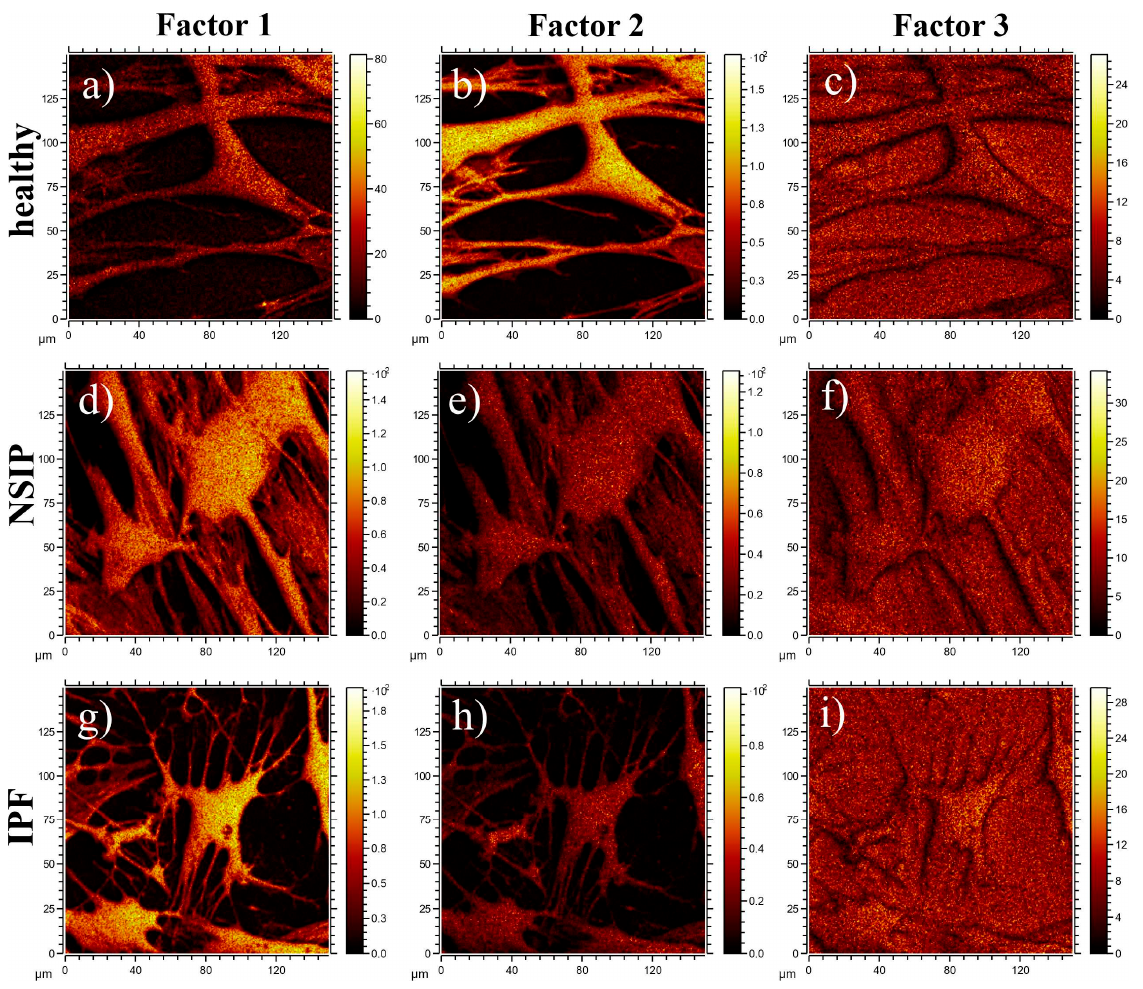
Figure 10. Spatial distribution of MCR factors 1 ( a , d , g ), 2 ( b , e , h ), and 3 ( c , f , i ) calculated for healthy ( a – c ), and NSIP- ( d – f ) and IPF-derived ( g – i ) fibroblasts.